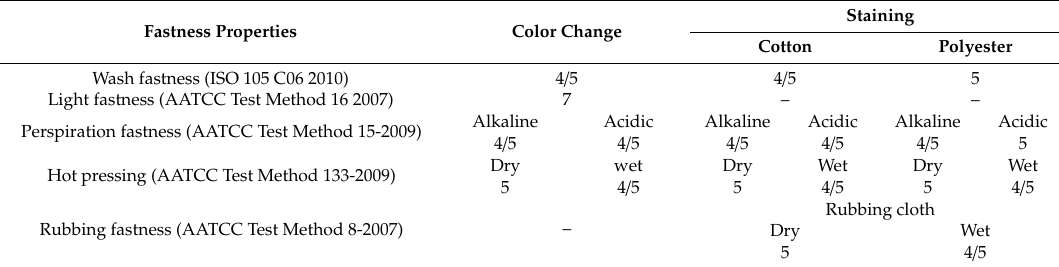
Table 7. E ff ect of di ff erent fastening agents on coated Table 7. Effect of different fastening agents on coated fabrics.